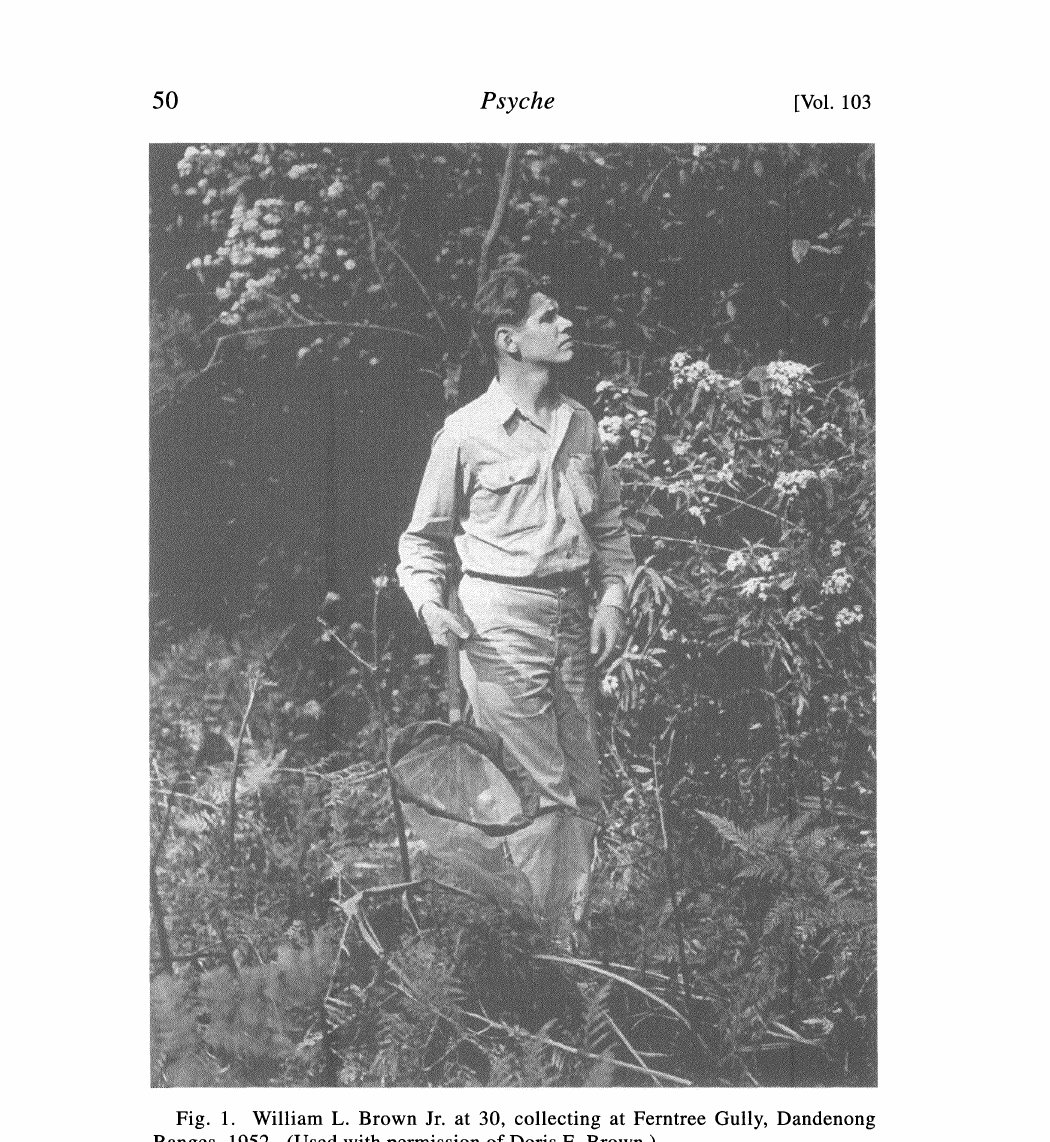
Fig. 1. William L. Brown Jr. at 30, collecting at Ferntree Gully, Dandenong Ranges, 1952. (Used with permission of Doris E.